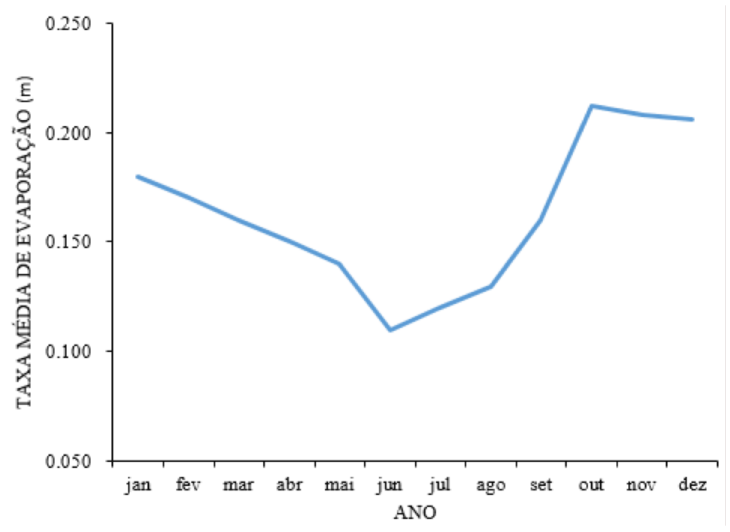
Figure 3. Average monthly